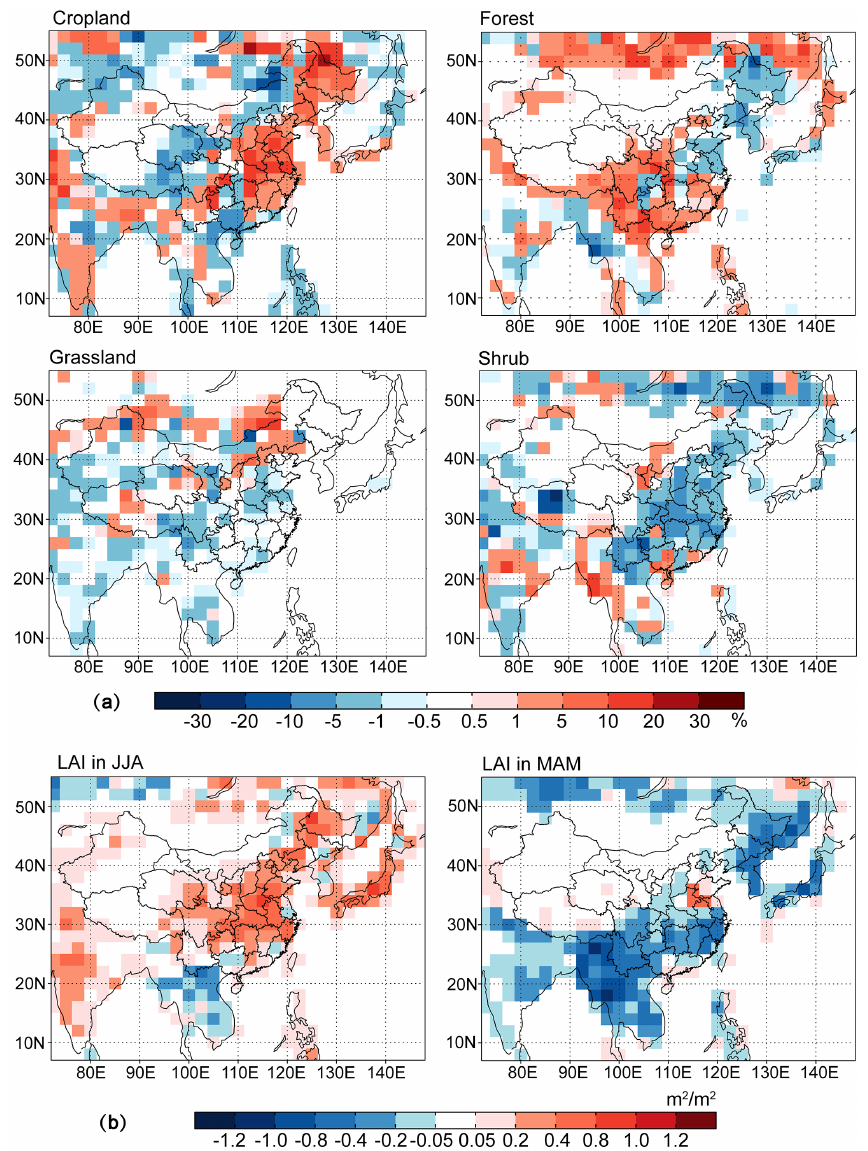
Figure 1. (a) 1980–2010 changes in fractional coverage of croplands, forests (needleleaf + broadleaf + mixed), grasslands and shrubs; (b) changes in summertime (JJA) and springtime (MAM) LAI between 1980 and 2010.